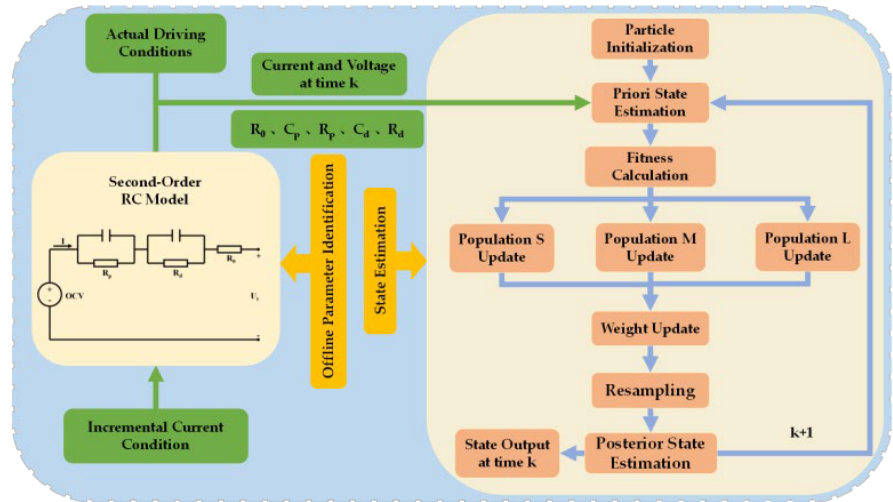
Figure 5. Flow Chart of the SOC Estimation.